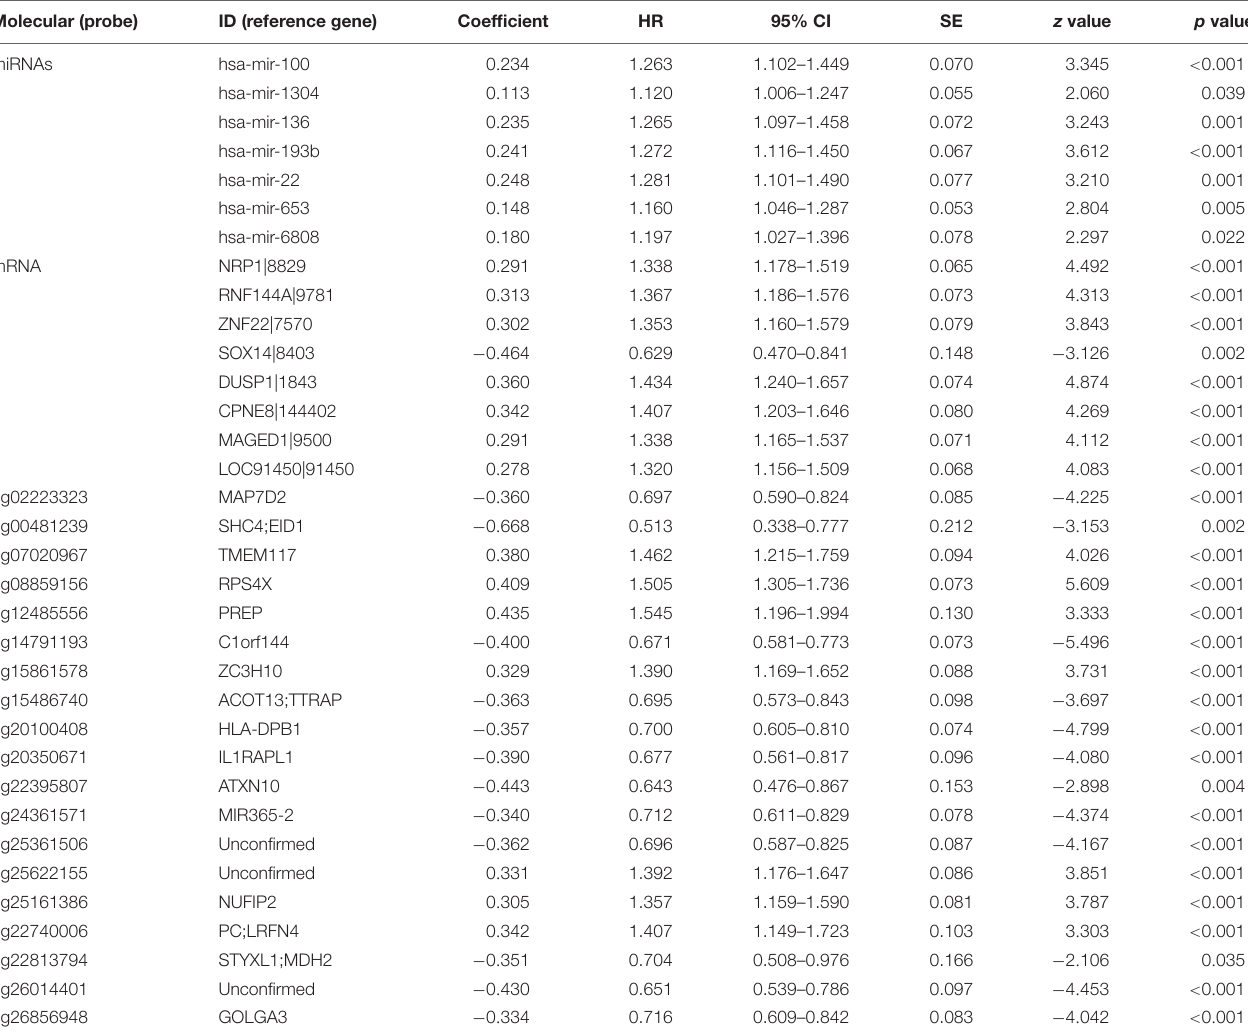
TABLE 2 | miRNAs, mRNA, and DNA methylation whose expression levels showed a significant association with overall survival in least absolute shrinkage and selection operator. Molecular